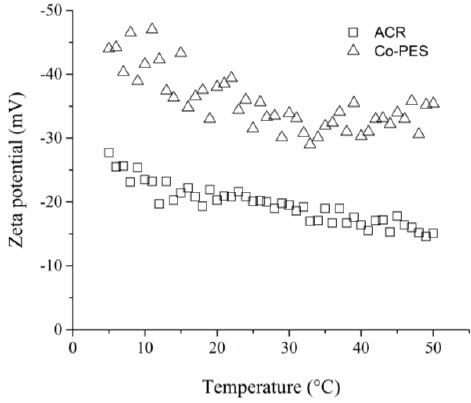
Figure 5. Zeta potential temperature dependence of ACR dispersion ( squares ) and Co-PES dispersion ( triangles ).